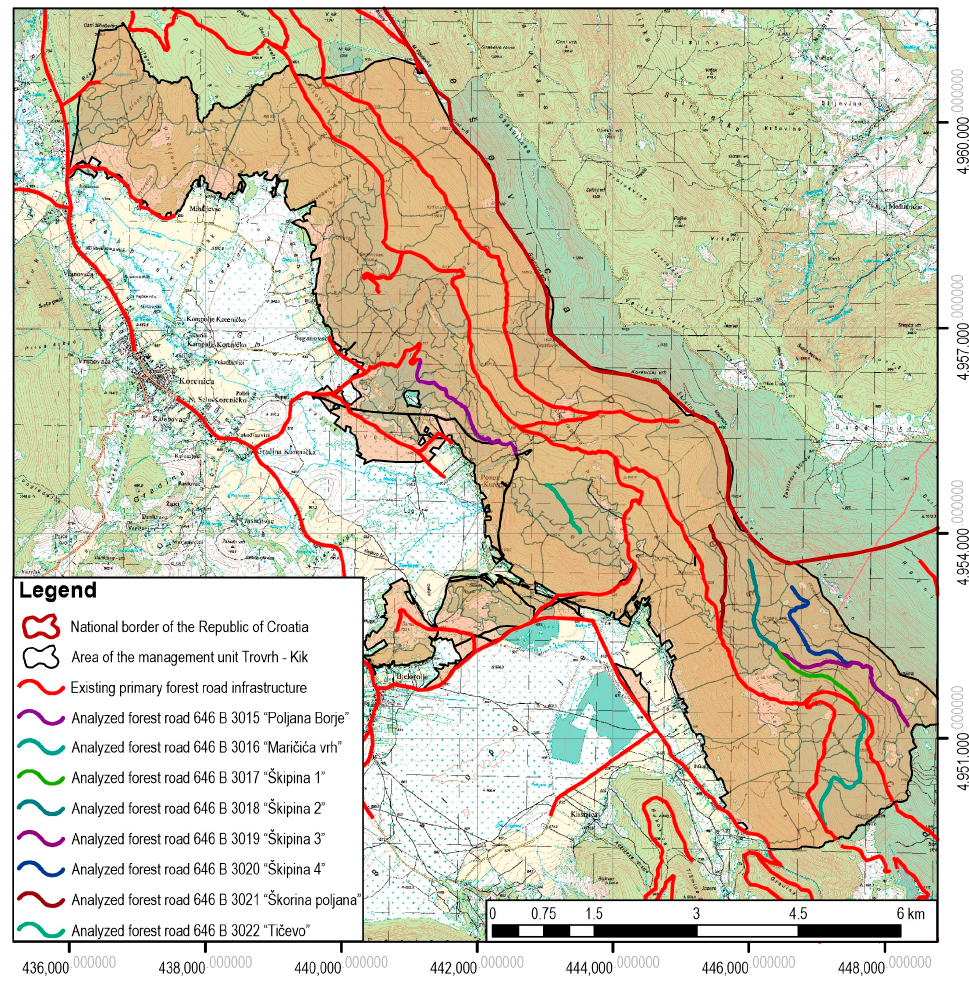
Figure 1. Map of research area.